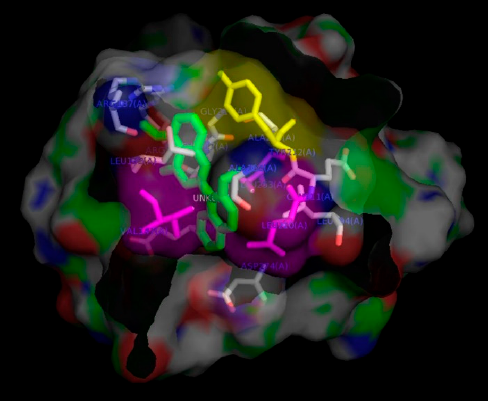
Figure 7. Image of the binding pocket of the AURKA–derivative 31 complex visualized using the PyMol program. Derivative 31 and Tyr212 are colored in green and yellow, respectively. Val147, Leu210 and Leu263 are marked in magenta color.